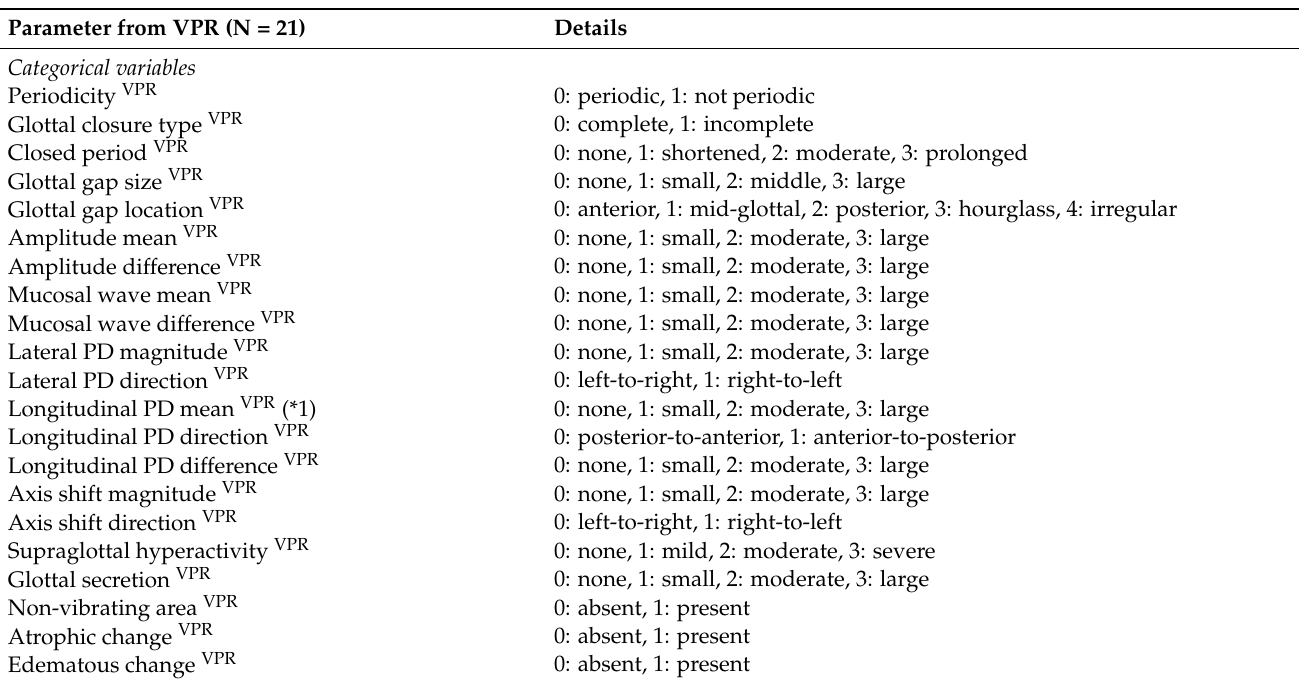
Table 2. Parameters from visual-perceptual rating